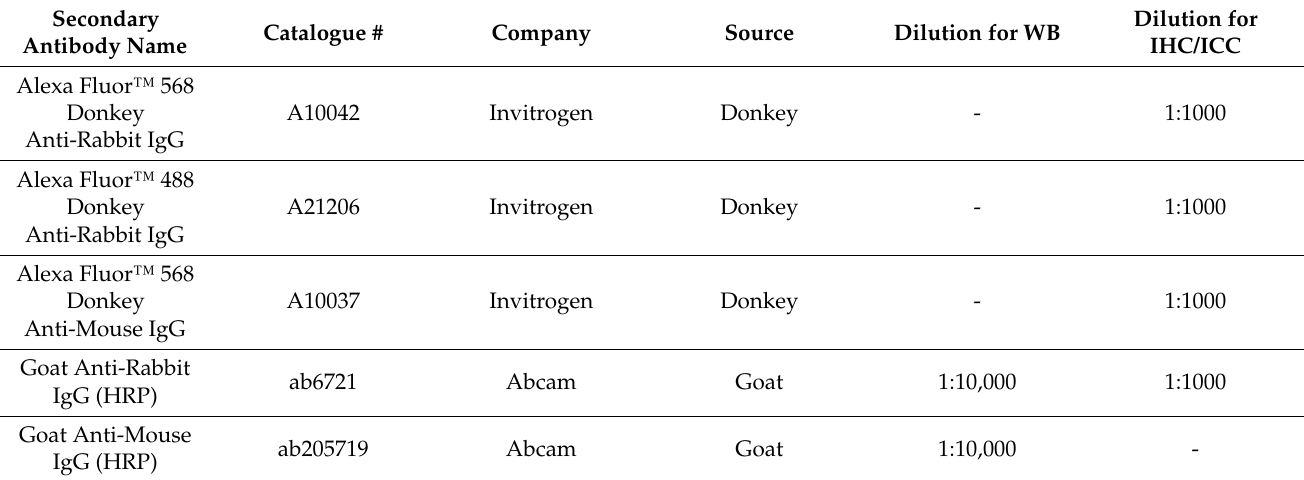
Table 2. Secondary antibodies used in Western Blotting (WB), Immunohistochemistry (IHC) and Immunocitochemistry (ICC)